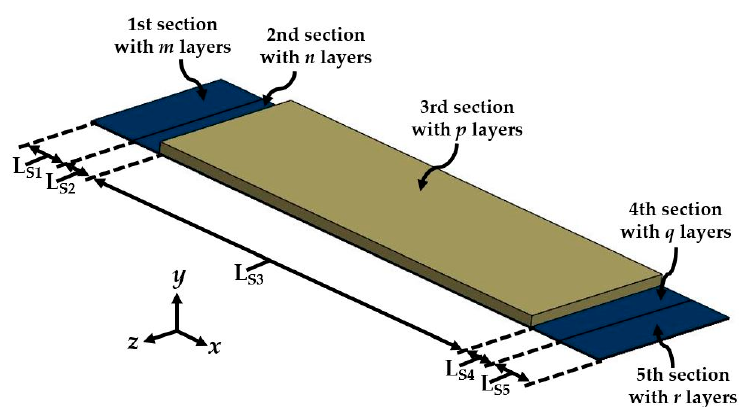
Figure 3. Schematic view of the piezoelectric nanogenerator with five multilayered sections.